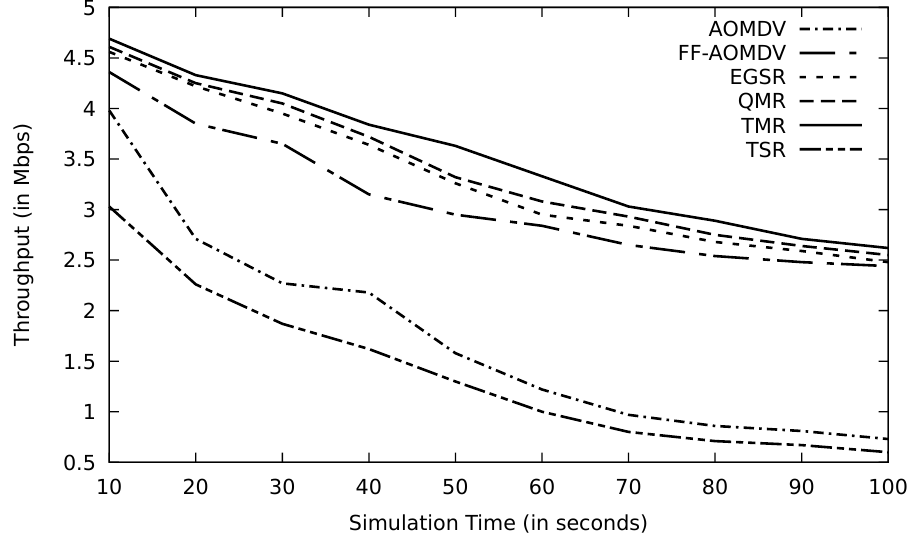
Figure 5. Comparison of AOMDV, FF-AOMDV, EGSR, QMR, and proposed protocol TMR and TSR throughput with simulation